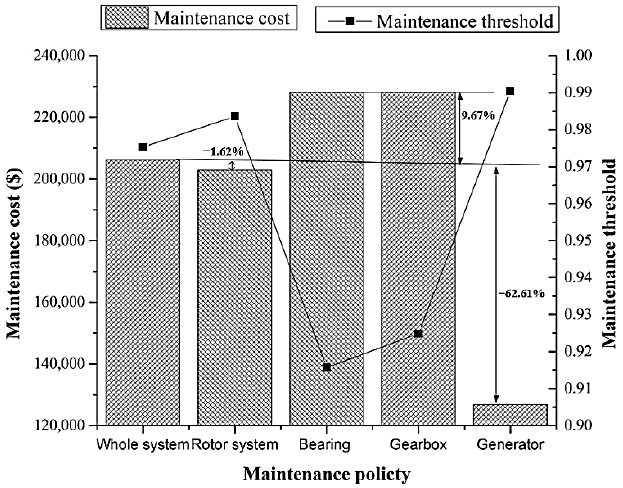
Figure 6. The maintenance cost as a function of maintenance threshold comparison .